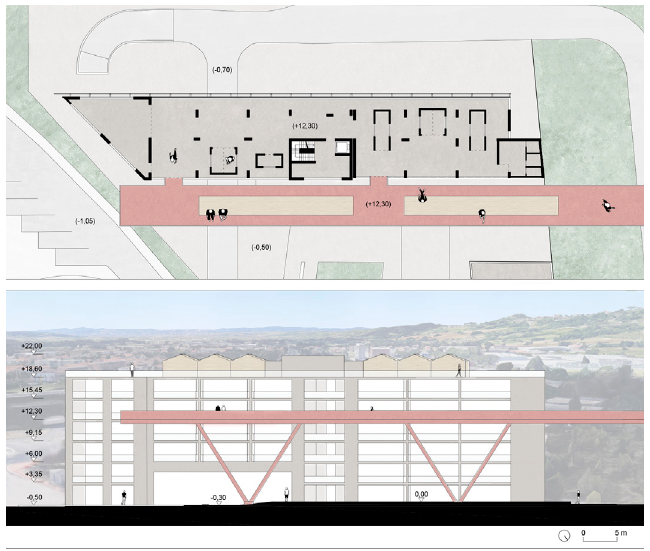
Fig. 3 Belardi, P., Battistoni, M., & Sorignani, C., junction between